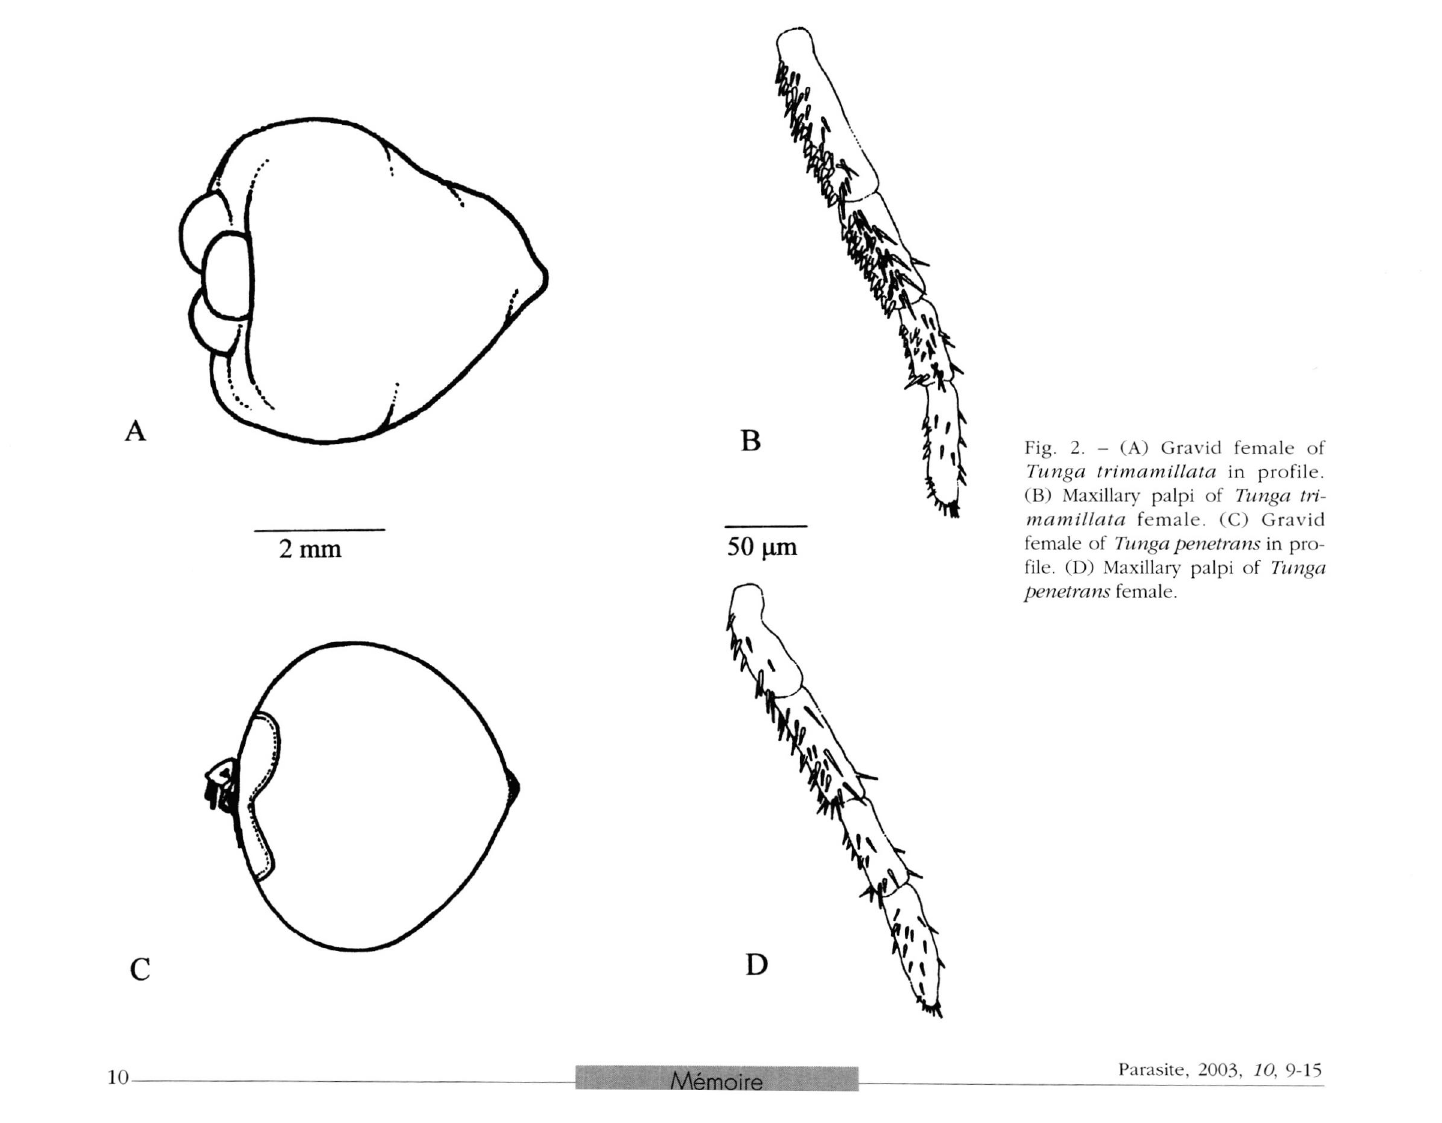
Fig. 2. - (A) Gravid female of Tunga trimamillata in profile. (B) Maxillary palpi of Tunga tri­ mamillata female. (C) Gravid female of Tunga penetrans in pro­ file. (D) Maxillary palpi of Tunga penetrans